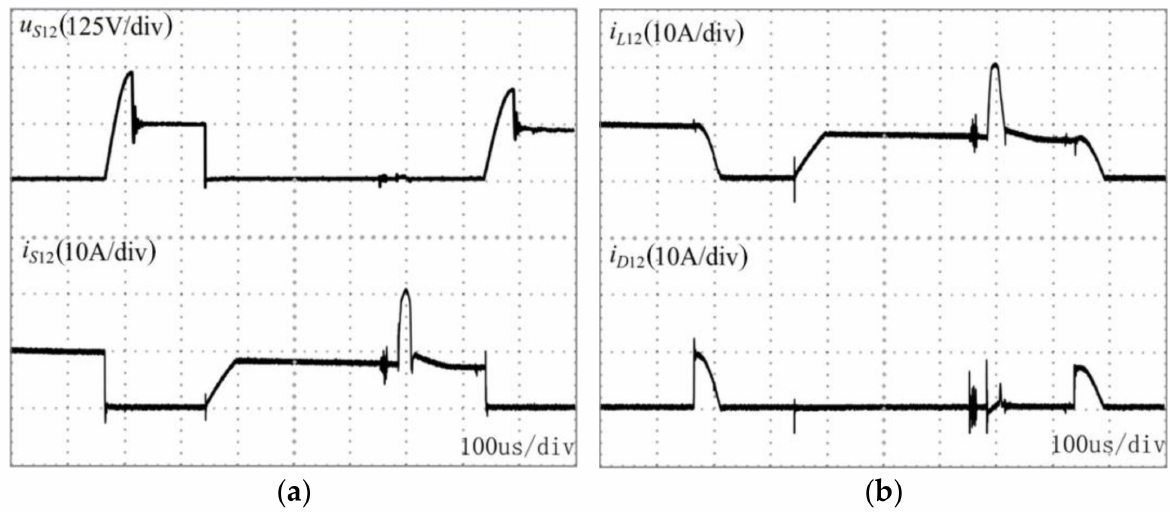
Figure 10. Waveforms of ( a ) voltage and current of switch S12, and ( b ) currents of inductor L12 and diode D12; the measurements were made for the same parameters as in Figure 9.